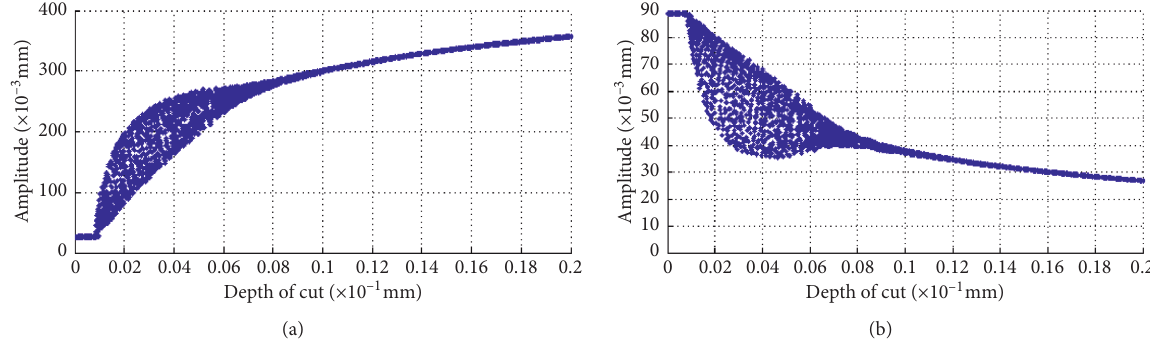
Figure 6: Bifurcation diagram of the grinding wheel displacement as a function of the depth of cut at the cutting speed of 30m/s. (a) Tangential direction. (b) Normal